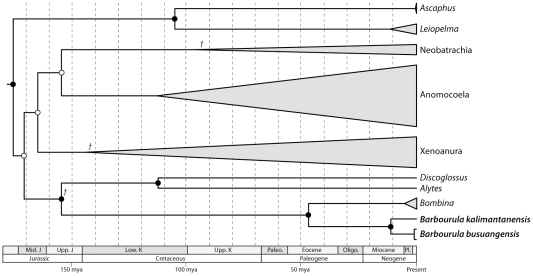
Time-calibrated phylogeny of Barbourula.Depicted is the MCCT and ML topology with divergence times (in mya) estimated using all five calibration points and standard deviations of 5.0 for their prior distributions. Nodes are at the inferred median heights with gray bars at selected nodes indicating the 95% HPD. Closed circles indicate high Bayesian and ML support (PP = 1.0; BS>90%); open circles indicate high Bayesian support only. Three of the five divergence time calibration points are indicated by crosses; the remaining two are either within Anomocoela or between Anura and Urodela (outgroup Urodela taxa are not shown; see also Figure S1).